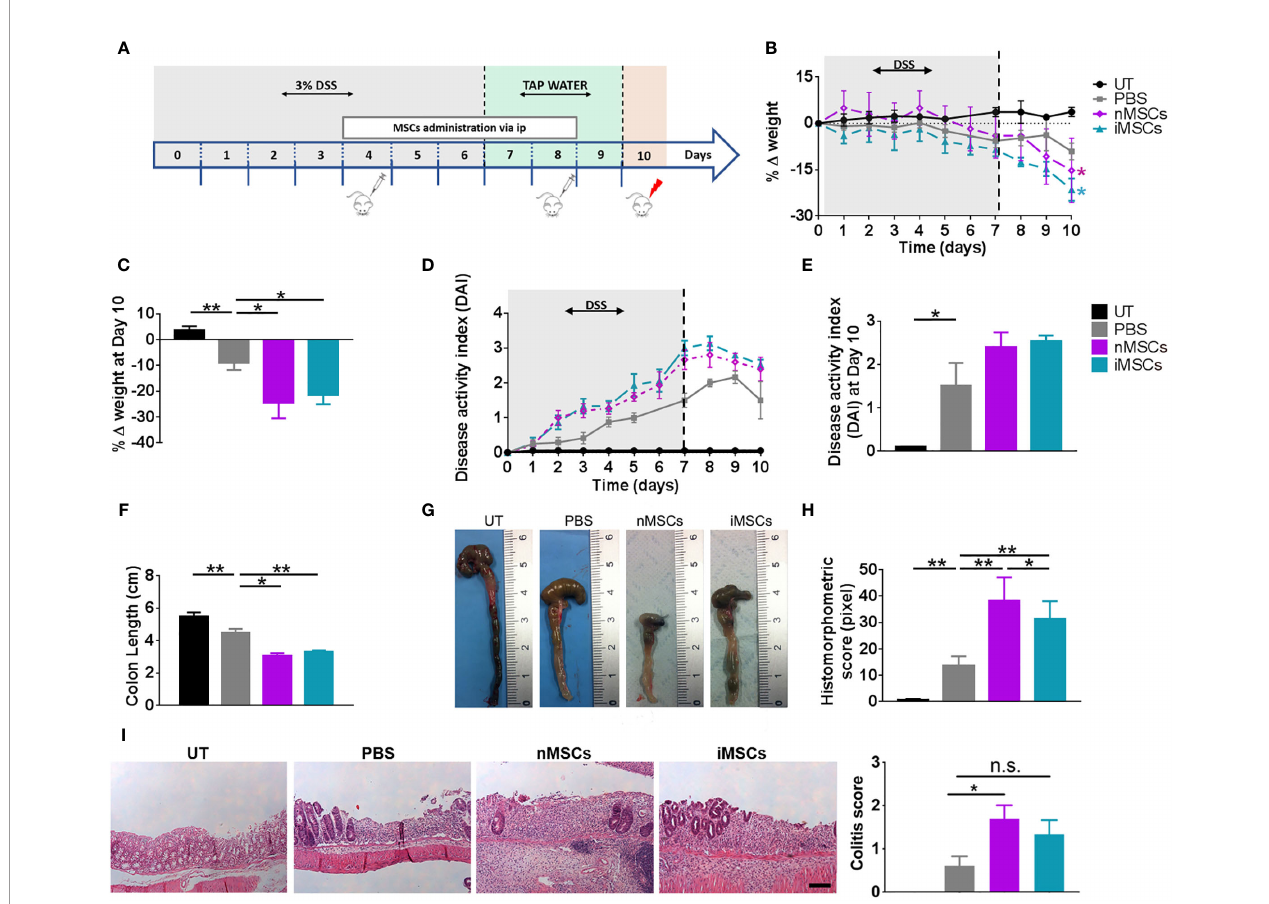
FIGURE 2 | MSC administration worsens colitis in mice. (A) Experimental design. DSS was given in drinking water for 6 days followed by three days on plain water. MSCs were injected intraperitoneally on days 4 and 8. Weight loss (B) , Percent weight loss (C) and disease activity scores (D) were determined daily. (E) Disease activity index at 10 days. Colon length (F, G) , histomorphometric score (H) and colitis score (I) were determined on day 10. Scale bars, 50 m m. Results are mean ± standard error (n = 5). *P < 0.05, **P < 0.01, n.s. = not signi fi